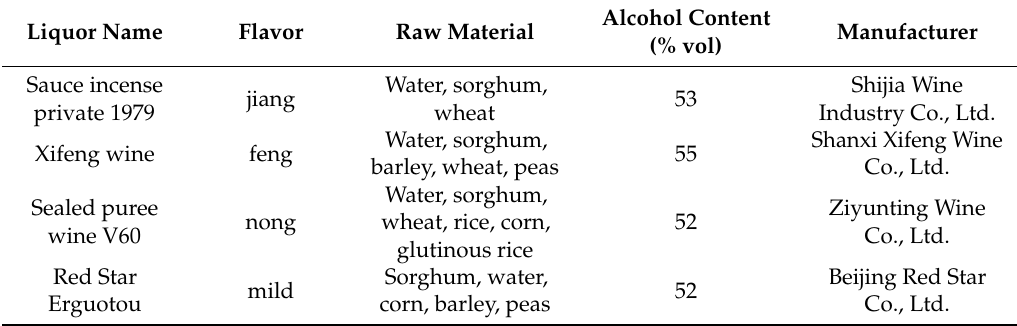
Table 1. Characteristics of sampled